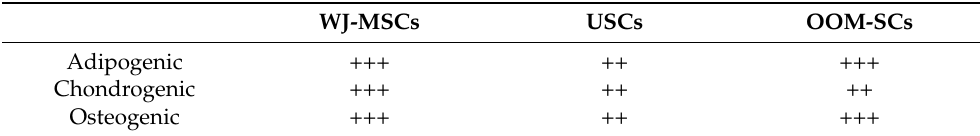
Table 3. Trilineage differentiation capacity of OOM-SCs compared with those of WJ-MSCs and